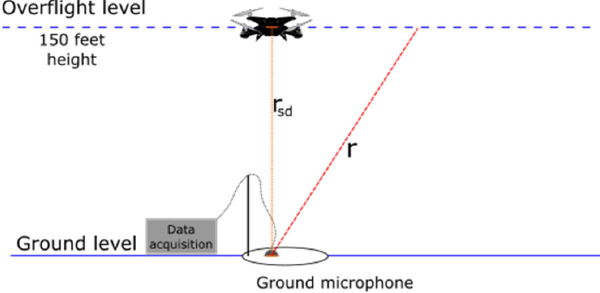
Figure 2. The measurement setup. Adapted with permission from Ref. [18].